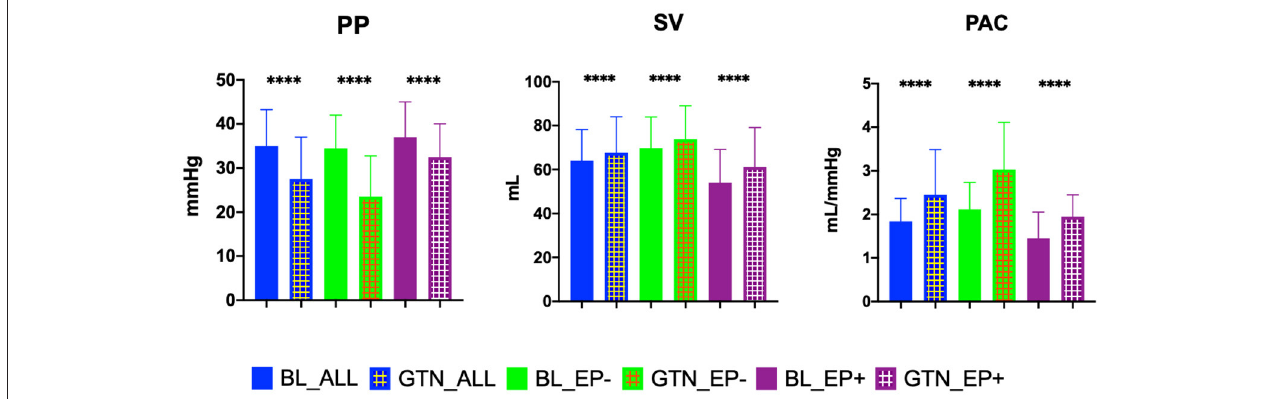
FIGURE 1 | Key hemodynamic parameters at baseline and after glyceryl trinitrate (GTN) application in all patients, in patients who did not reach the endpoint transplant/LVAD free survival (EP-), and in patients reaching the endpoint (EP + ). PP, pulse pressure; SV, stroke volume; PAC, pulmonary arterial compliance; BL, baseline. **** P <